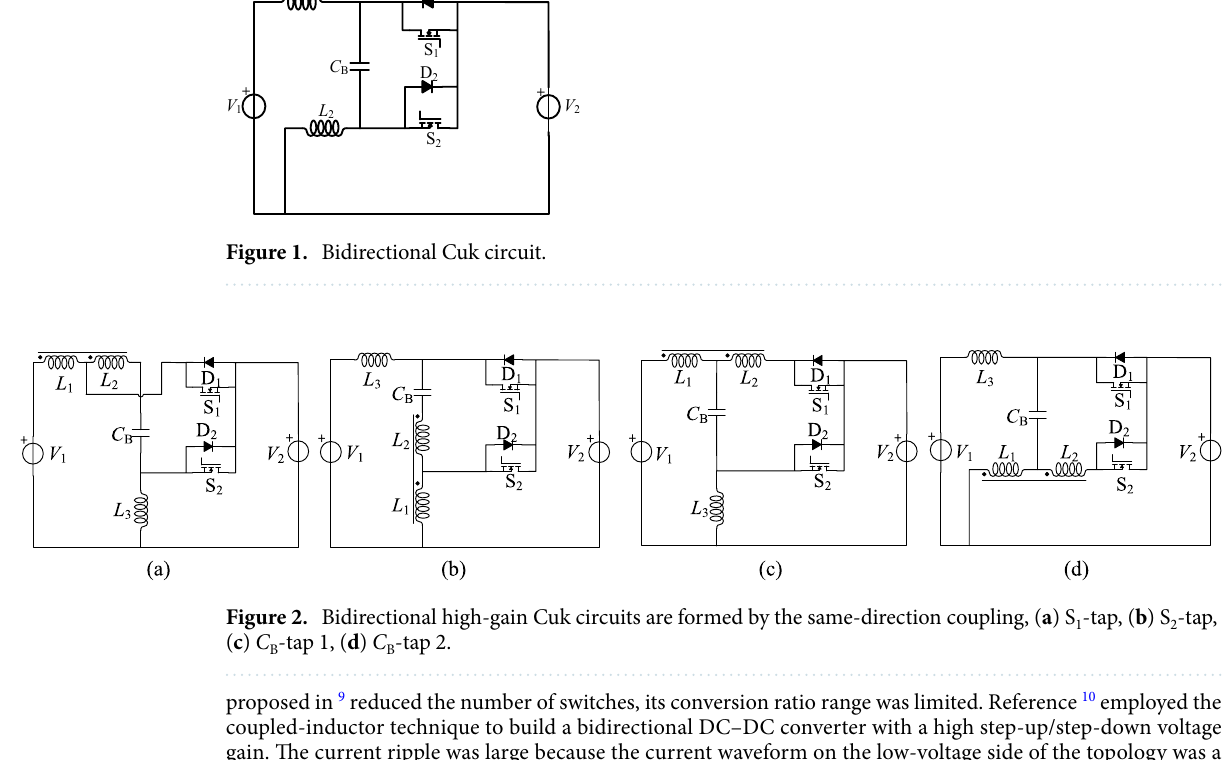
Table 1. S 1 -tap means that the inductor L 1 of the bidirectional Cuk circuit is replaced by the tap inductor L t , and the common terminal of the tapped inductor is connected to S 1 , as shown in Fig. 2a and Fig. 3a. S 2 -tap means